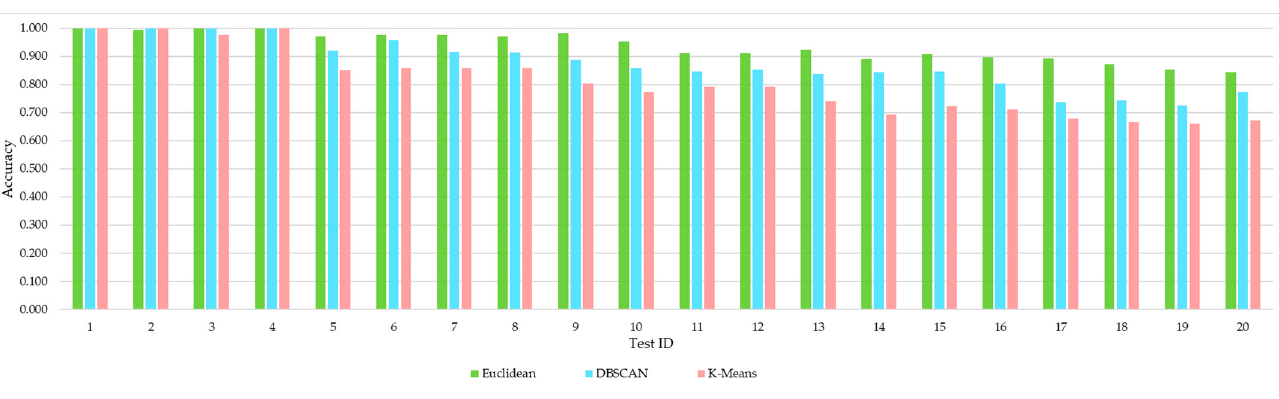
Figure 14. This image depicts the top view of a point cloud in a static use case, tilted to the right by five people leaning forward in the car. The original point cloud image is on the left ( a ), while the right ( b ) shows the result of clustering and post-processing. Different colors are used to represent different categories of point clouds, with the positive Y -axis pointing towards the front.